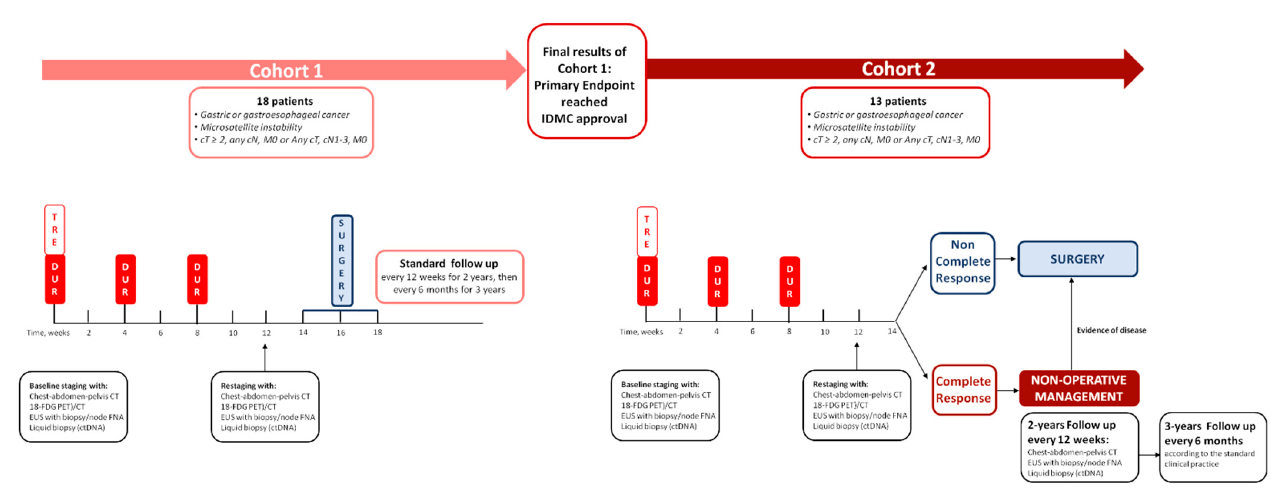
Figure 1. This figure illustrates the INFINITY study